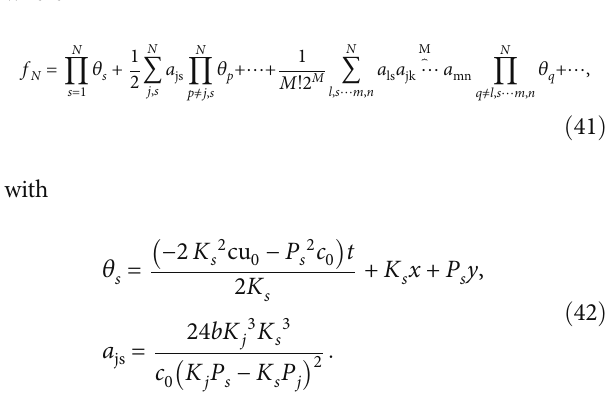
Figure 4: Two types of second-order lump solutions in Equation (1) with parameters b = − 1 , c K 3 = − 2 + i , K 4 = − 2 − i , P 3 = − 2 , and P 4 = − 2 at t = 0 . (a) Bright-type lump with u 0 = 1 and c = − 1 . (b) Dark-type lump with u 0 = − 1 and c = 1